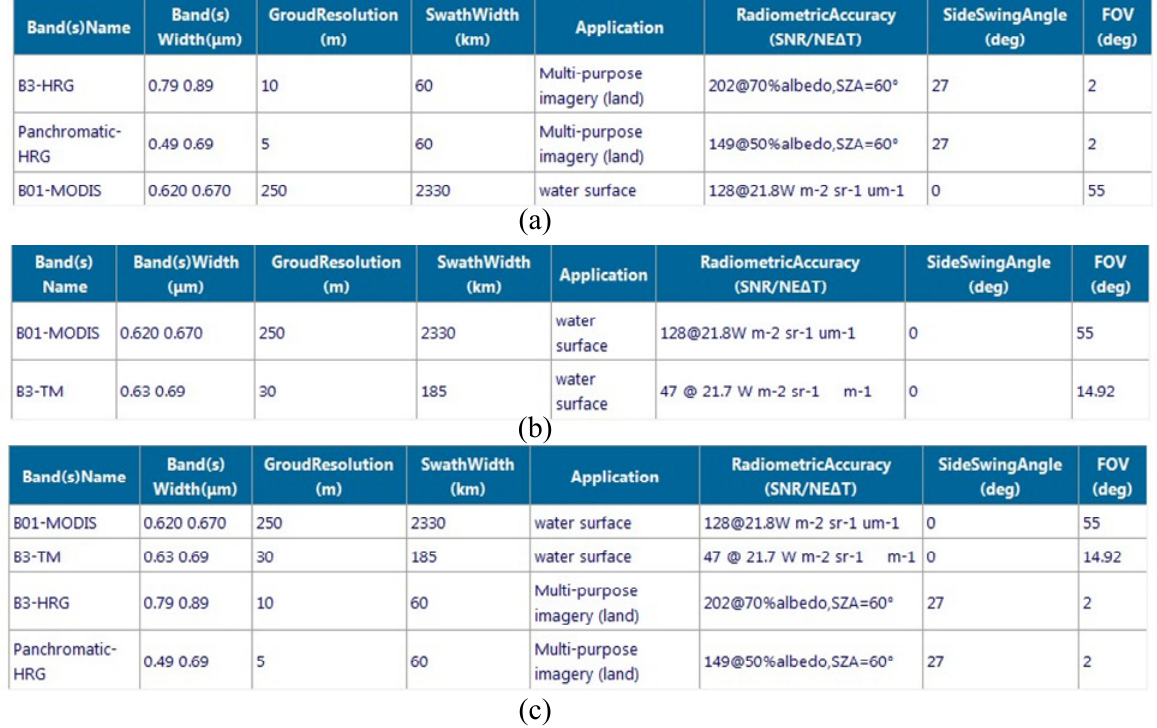
Figure 7. Useful observation information extracted from the corresponding new RS_rs of